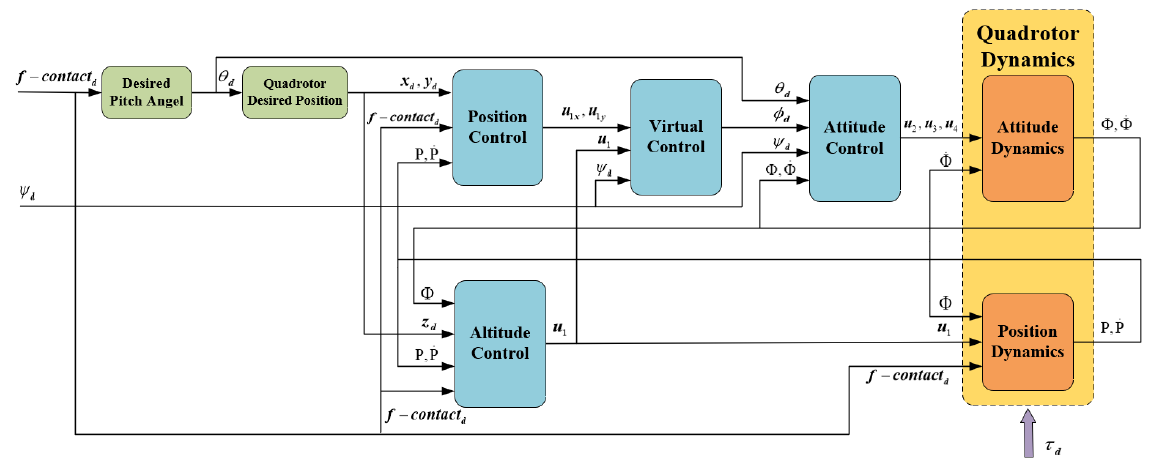
Figure 4. The structure of the double-loop control scheme based on contact force